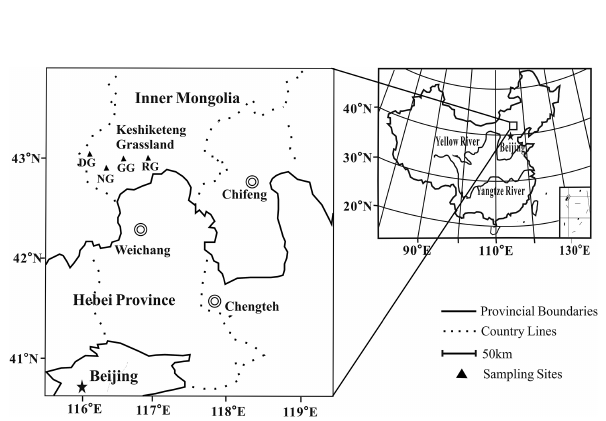
Figure A1. Map of the sampling sites in Inner Mongolia, northern China.